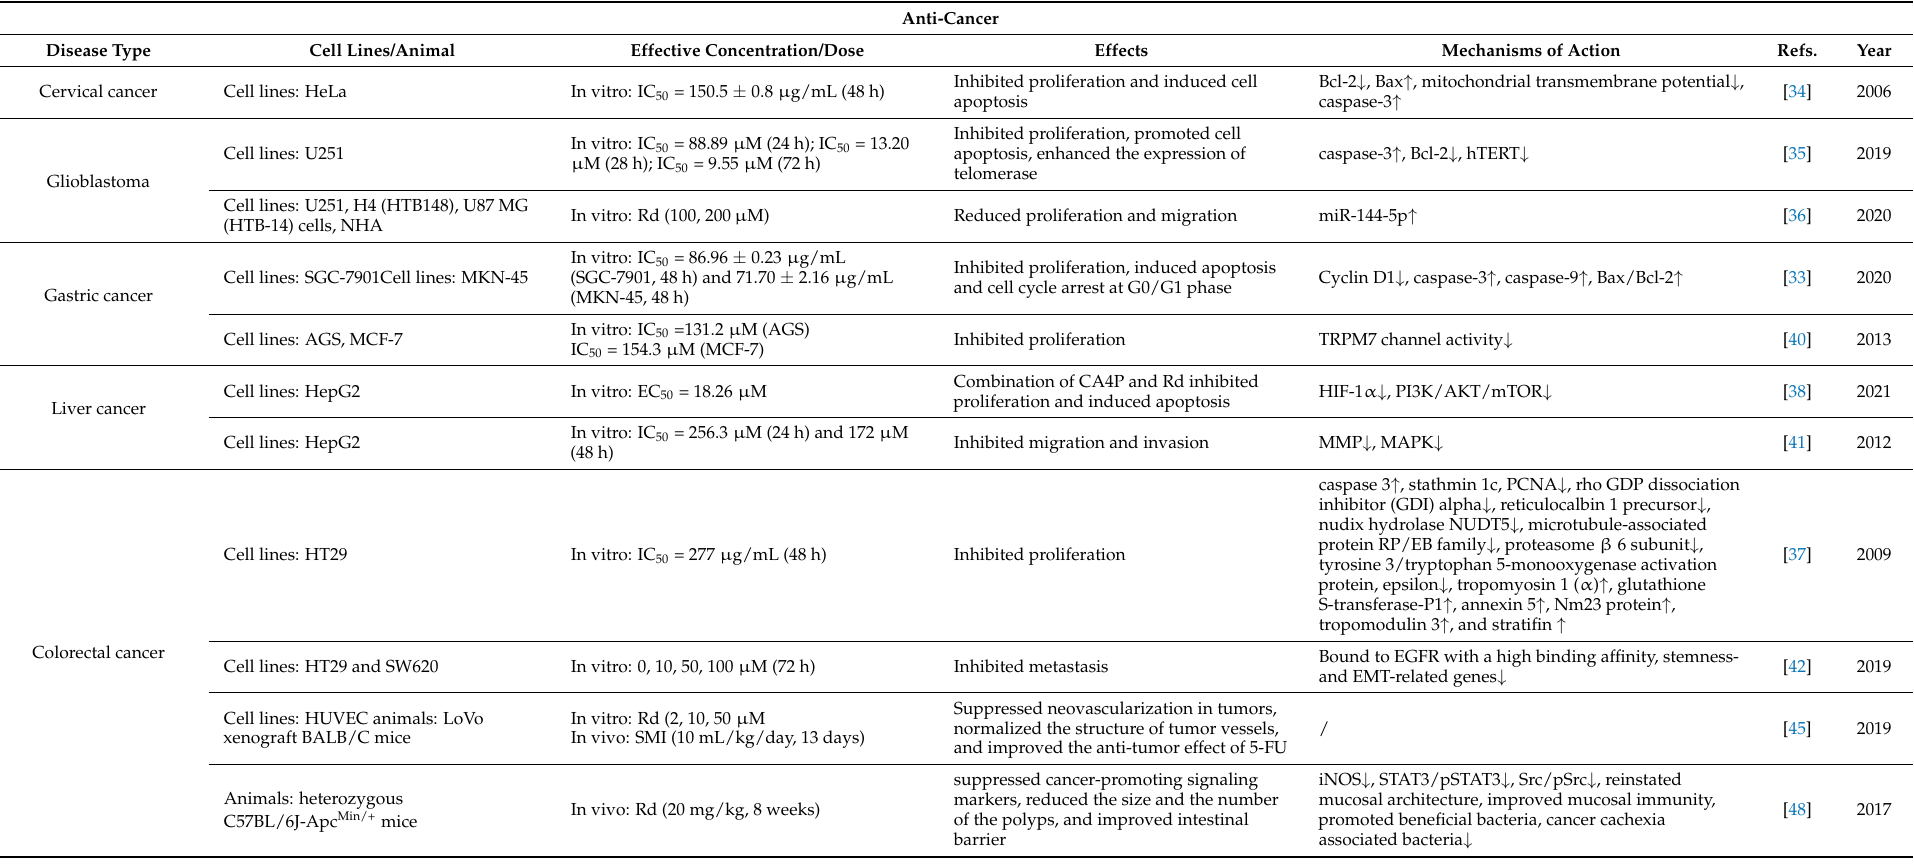
Table 2. Anti-cancer and anti-diabetic effects and the molecular mechanisms of